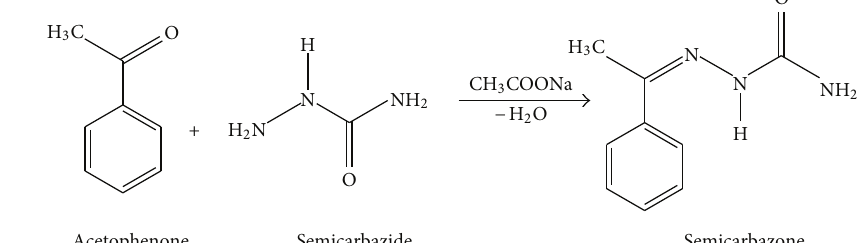
F 1: Syntheses of ionophore.